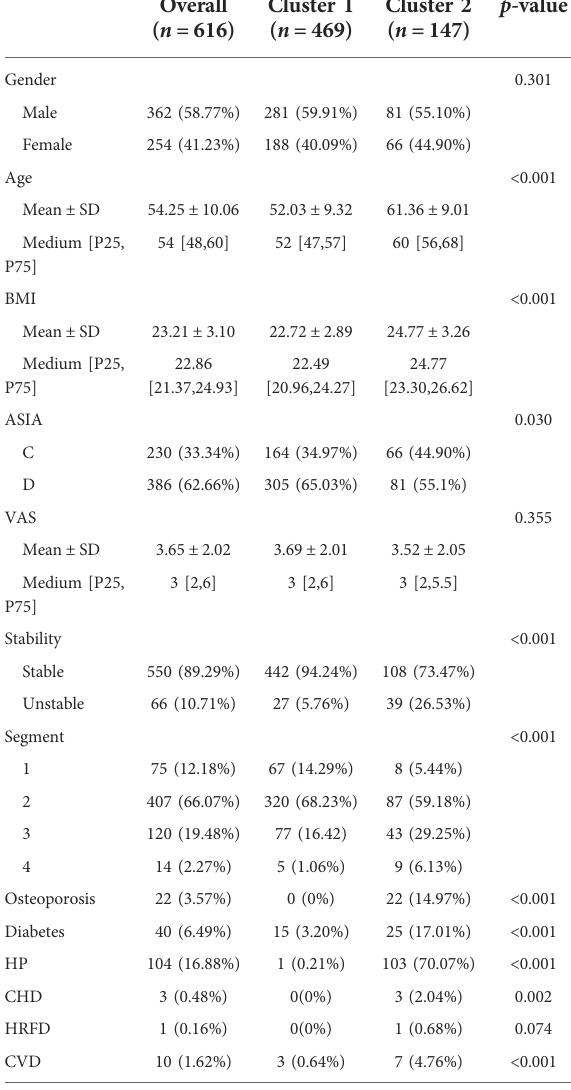
TABLE 1 Baseline characteristics of the study patients by